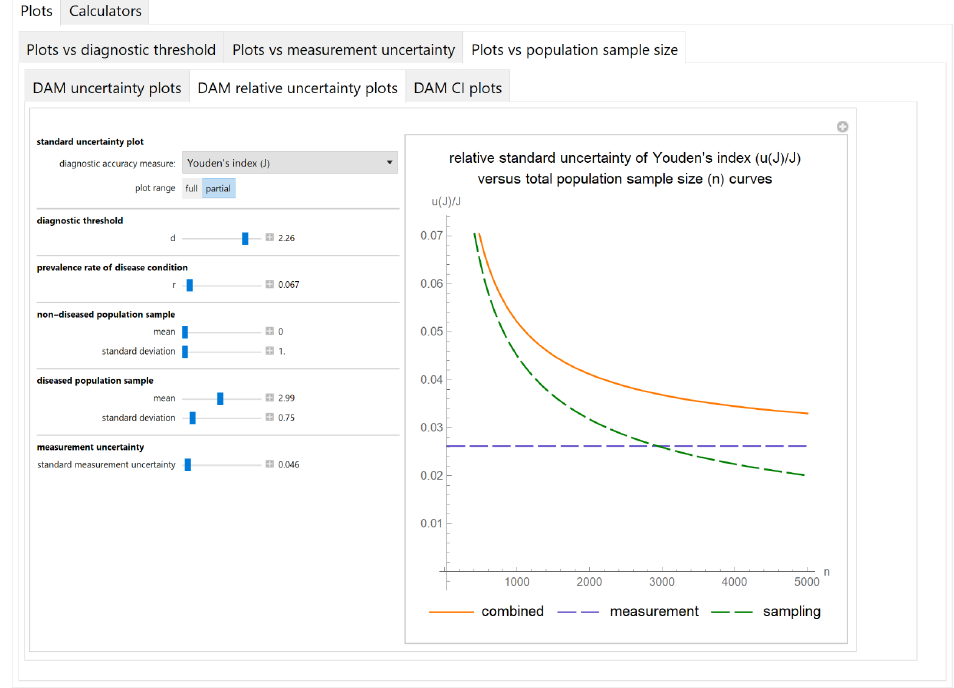
Figure 10. Plots vs. population sample size module, DAM relative uncertainty plots submodule screenshot. Relative standard combined, measurement and sampling uncertainty of Youden’s index ( u(J)/J ) versus total population sample size ( n ) curves plot, with the settings shown on the left. The respective parameter settings are also shown in Table 3. Confidence Intervals of Diagnostic Accuracy Measures Plots Submodule The values of the lower and upper bounds of the confidence intervals of diagnostic accuracy measures of a screening or diagnostic test, at a selected confidence level, are plotted versus the total population sample size (Figure 11).